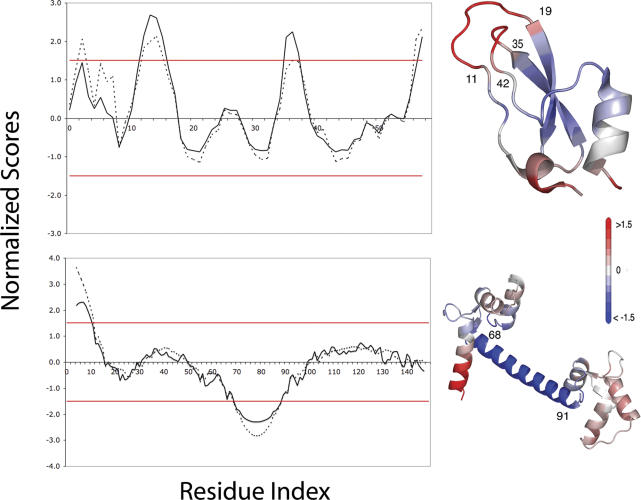
FF Score Identifies FFR in Bovine Pancreatic Inhibitor and CalmodulinComparison of unweighted (dashed line) and weighted (solid line) FF scores for BPTI ([top], PDB ID: 5PTI) and calmodulin (bottom, PDB ID: 1CLL). FF scores are mapped with the same gradient coloring from negative (blue) to positive (red) as the scale shown in Figure 1D. Both recognition loops (loop 1: residues 11 to 19; loop 2: residues 35 to 42) are identified in BPTI by the FF score, whereas loop 2 is not identified with the unweighted mode. For calmodulin, the FF score allows us to identify the central hinge for this protein (residues 68 to 91 shown in blue because it exceeds the negative threshold of less than −1.5). This central helix, containing eight turns, is known to collapse when bound to calcium and substrate.